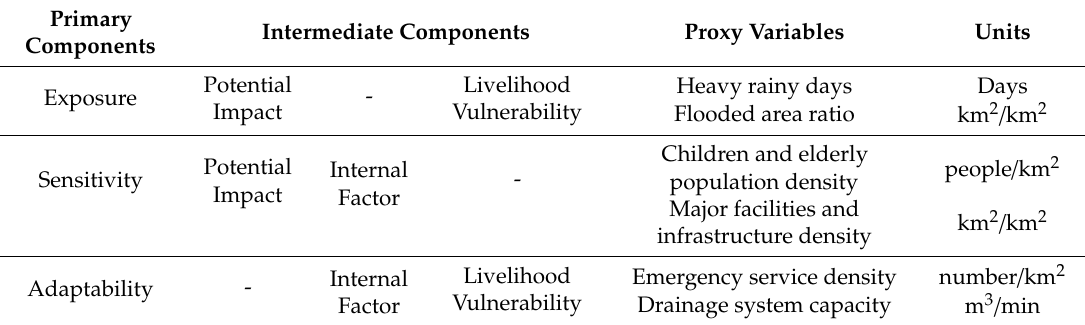
Table 1. The proxy variables selected for the flood vulnerability assessment in the three primary components, exposure, sensitivity, and adaptability, based on the concept of the IPCC